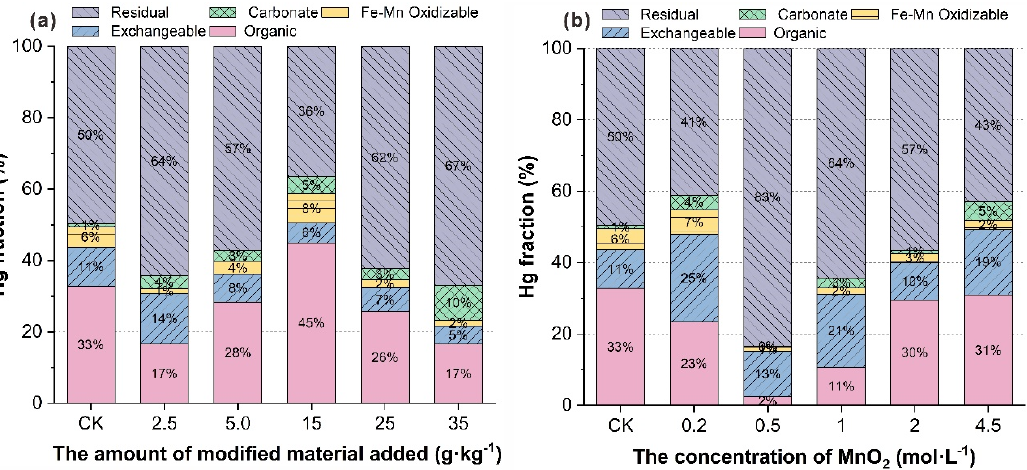
Figure 4. Speciation of mercury in soil modified by different materials, and by different manganese dioxide concentrations.